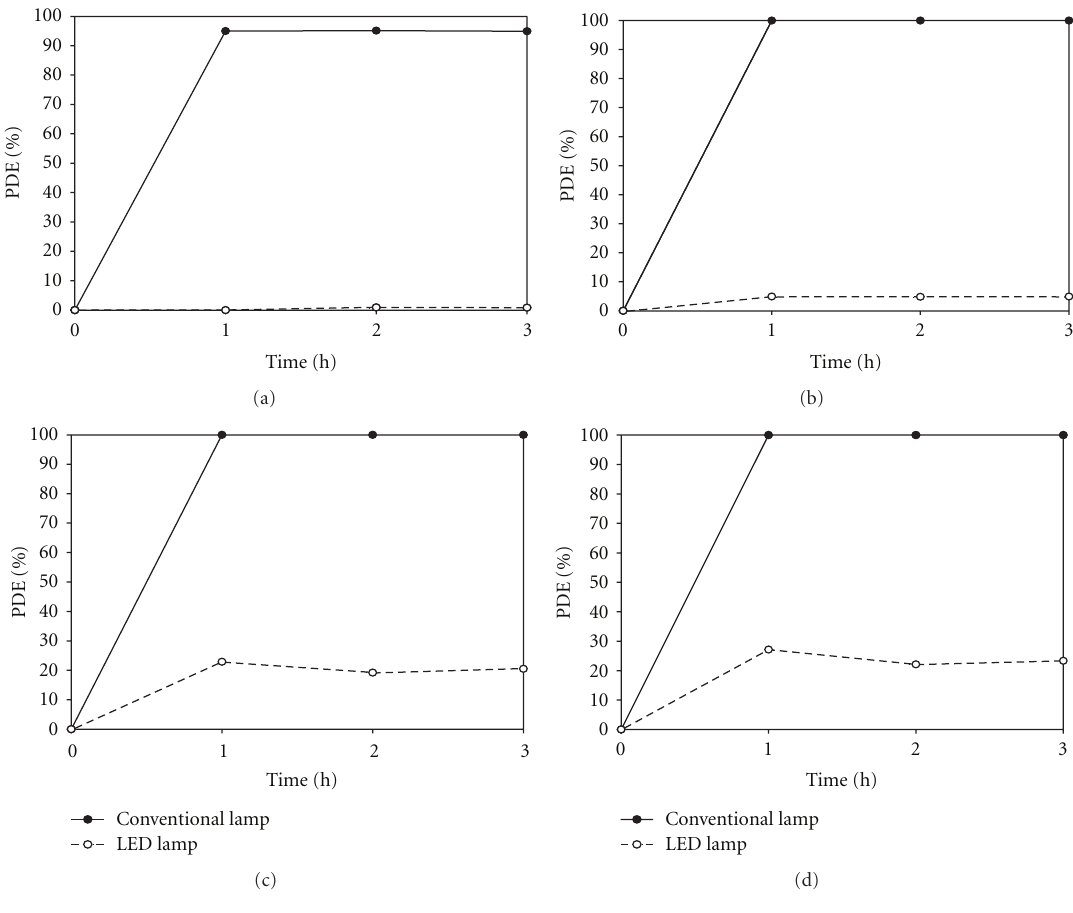
Figure 7: Time-series photocatalytic decomposition e ffi ciencies determined via MWNT-TiO 2 irradiated using two light-source types (conventional 8-W black light lamp and blue-LEDs): benzene (a), toluene (b), ethyl benzene (c), and o-xylene